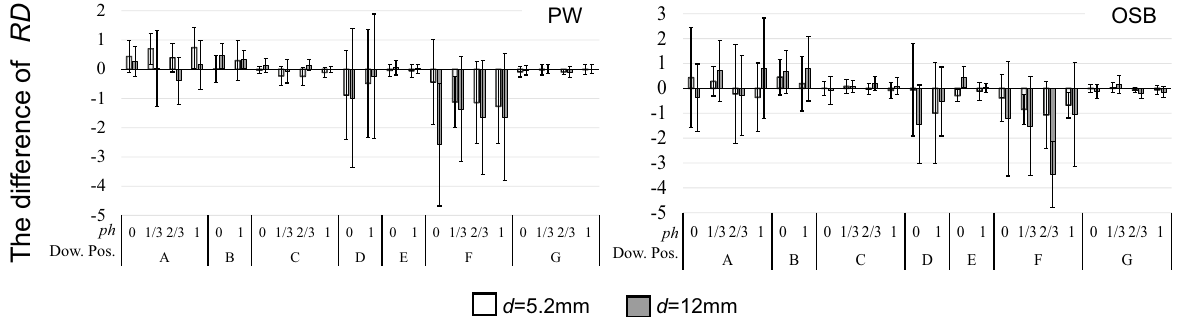
Fig. 13 Comparison of RD differences between strong and weak axial specifications. Values of “strong axial specification—weak axial specification” are presented. Error bars indicate standard